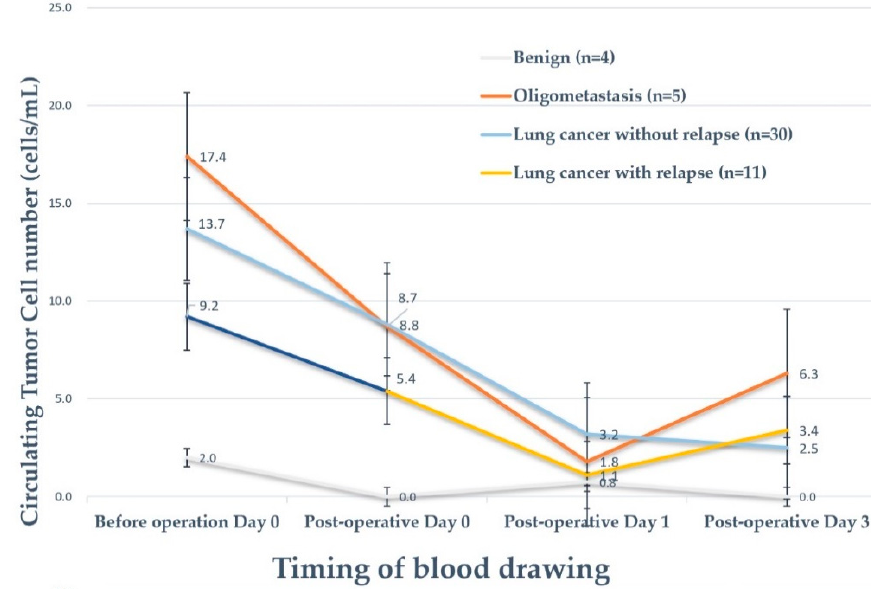
Figure 3. The rebound of circulating tumor cell counts correlates to minimal residual disease. In this figure, a rebound of mean CTC number was observed on day three after surgery in both oligometastasis group (red) and primary lung cancer with recurrence group (green), indicating possible minimal residual tumor signals in blood after surgery.